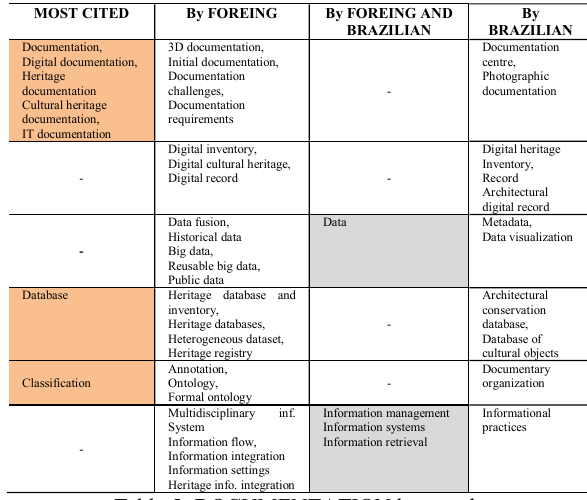
Table 5: DOCUMENTATION keywords